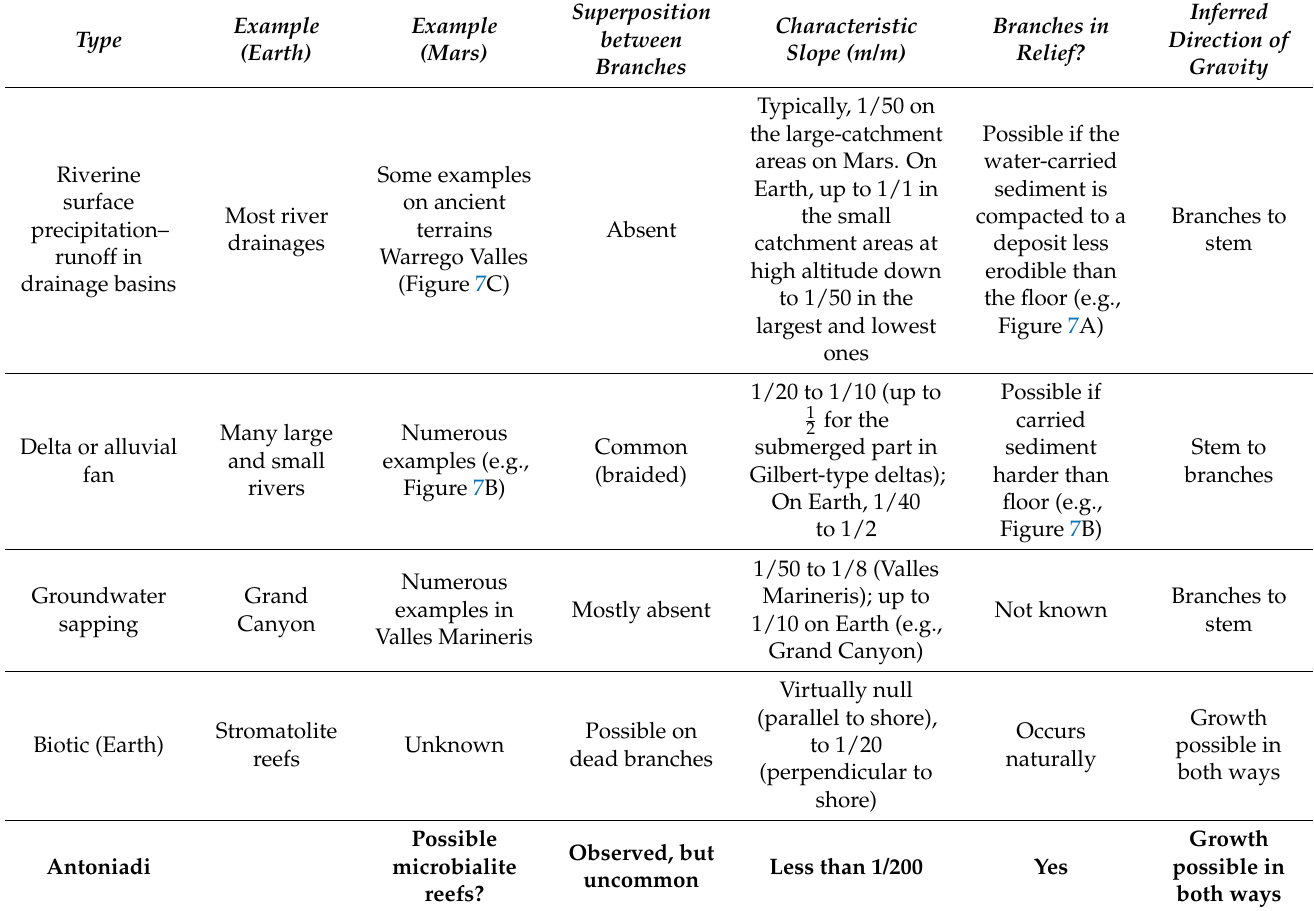
Table 1. Comparison between the patterns developed by riverine surface precipitation–runoff, delta and alluvial fans, groundwater sapping, biotic reefs, and the dendrites in Antoniadi crater. Data include references to some typical examples on Earth and Mars, superposition between branches, characteristic slope, the possibility that dendrites may form a relief, and the direction of gravity (from branches to stem or from stem to branches) that could be inferred without following terrain deformation. Characteristic slope data for deltas or alluvial fans (measured along the gradient direction) are from [15], while the other slopes for Mars have been measured with MOLA, taking a number of representative sections along the direction of the